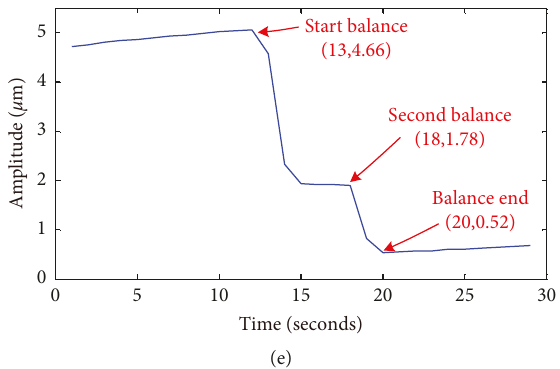
Figure 21: Comparison of balance information in the X - Y direction at 18,000rpm. (a) X -time domain. (b) Y -time domain. (c) X -frequency domain. (d) Y -frequency domain. (e) Online balance